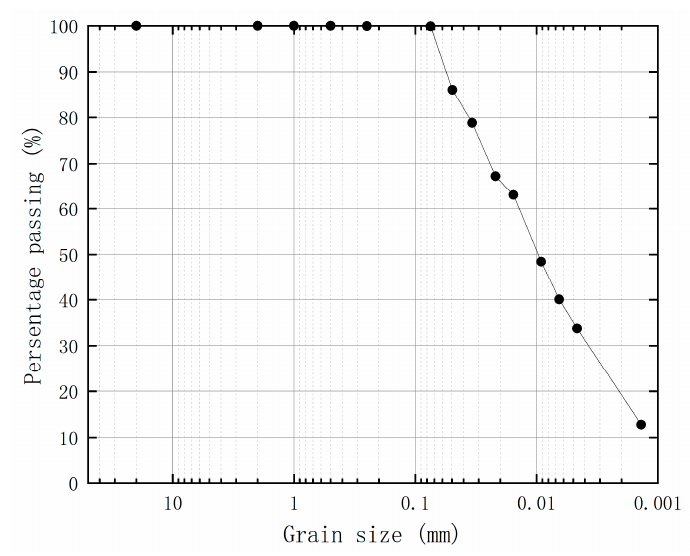
Figure 2. Grain size distribution of the dredger soil.